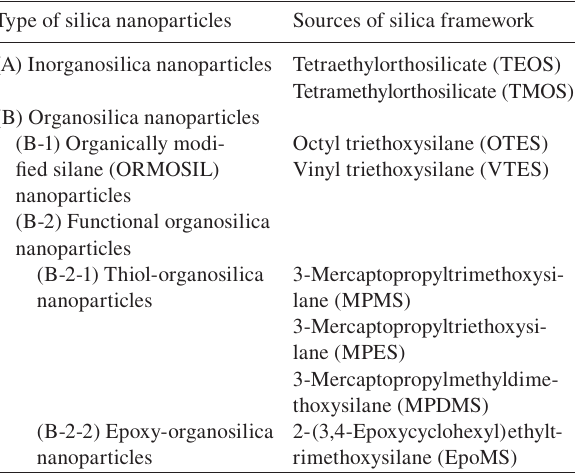
Table 1 Classifi cation of silica nanoparticles and their source of silica